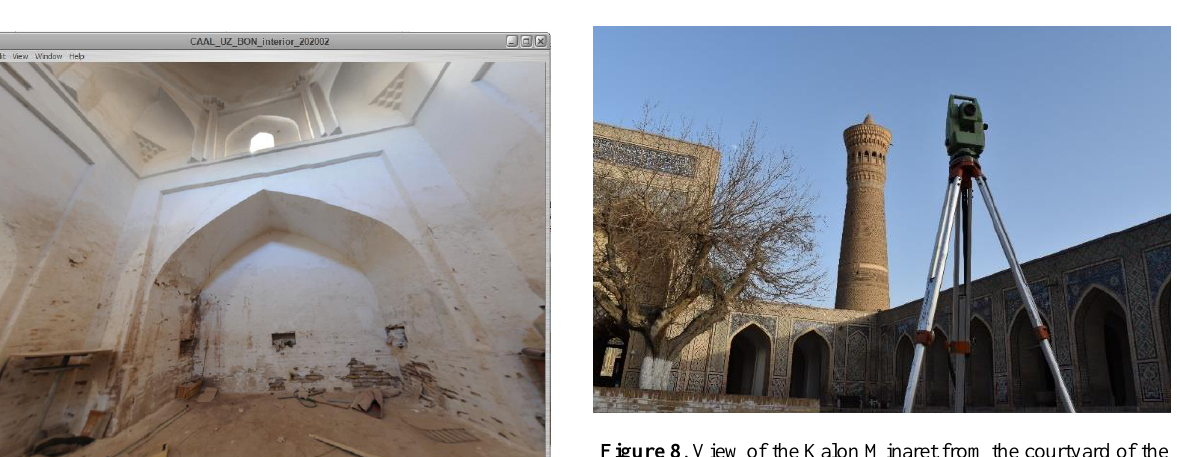
Figure 8 . View of the Kalon Minaret from the courtyard of the Kalon Mosque. Source: